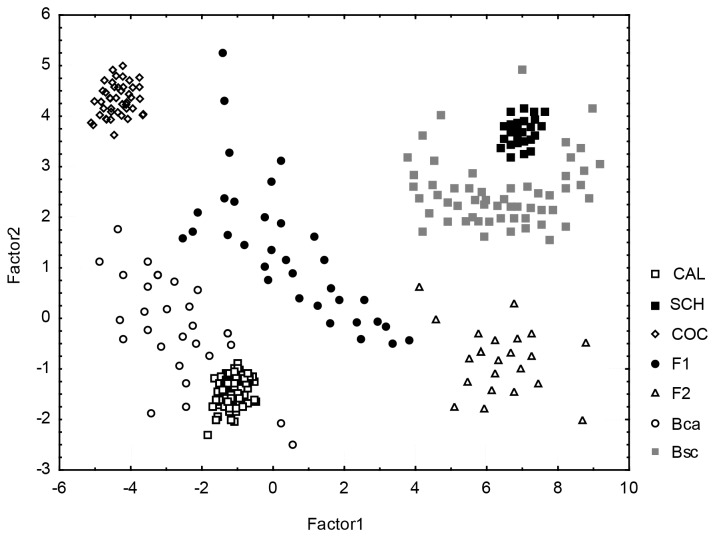
Scatter plot of the principal component analysis (PCA) of morphological variations in the pure parental species, Epidendrum
calanthum (CAL), E. schistochilum (SCH), and E. cochlidium (COC) and the hybrid generations (F1, F2 and the two backcrossed hybrids, Bca and Bsc) grown in their natural habitats.Genetic groups were gathered using NEWHYBRIDS.